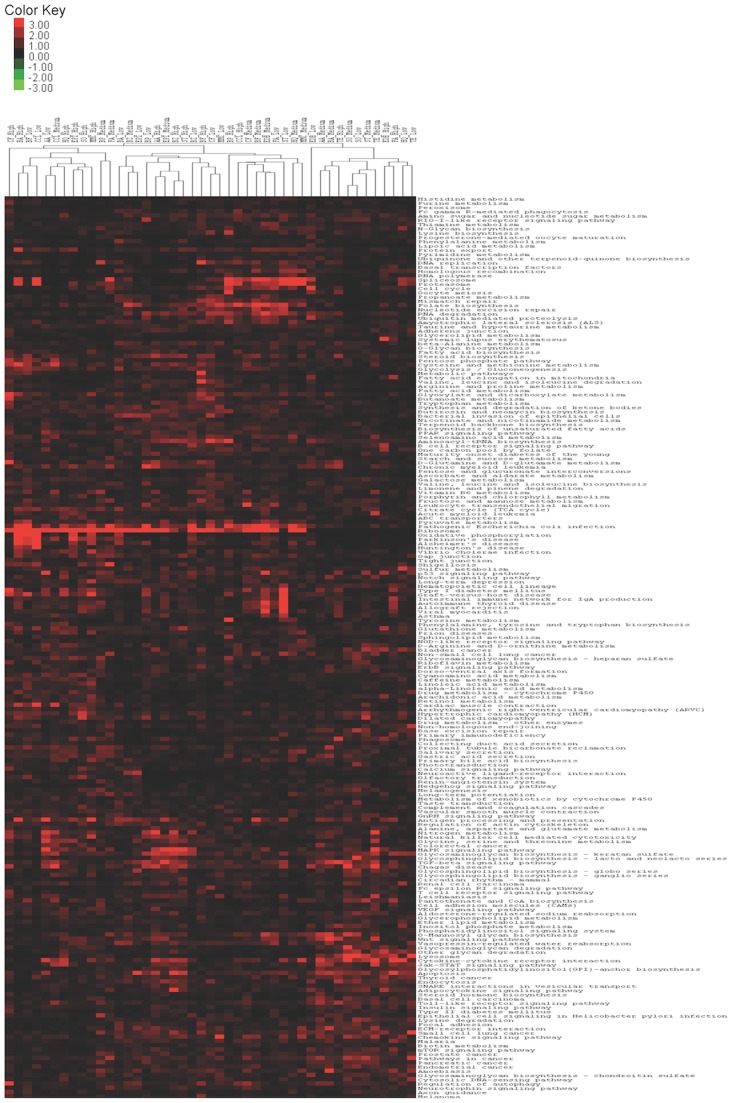
Heatmap generated by hierarchical clustering of chemical-dose arrays.Heatmap representation of the hierarchical trees of pathways and differentially expressed genes in each chemicals-dose combination generated using hierarchical clustering with the Euclidean distance metric and average linkage method. The columns in the Heatmap correspond to each chemical-dose combination and rows correspond to different KEGG human pathways. Significantly impacted genes from the respective biological replicates per chemical were pooled in the hierarchical clustering.